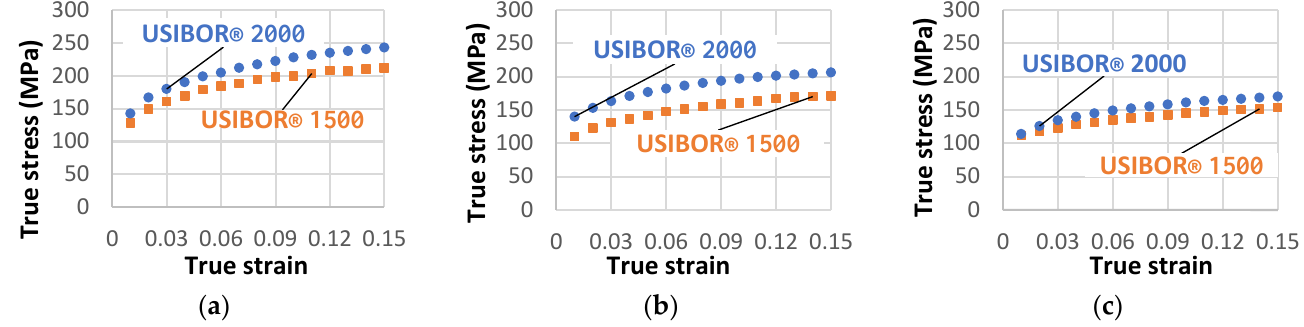
Figure 19. Comparison between the two investigated UHSS at the strain rate of 0.1 s − 1 and test temperatures of ( a ) 750 °C, ( b ) 800 °C and ( c ) 850 °C.